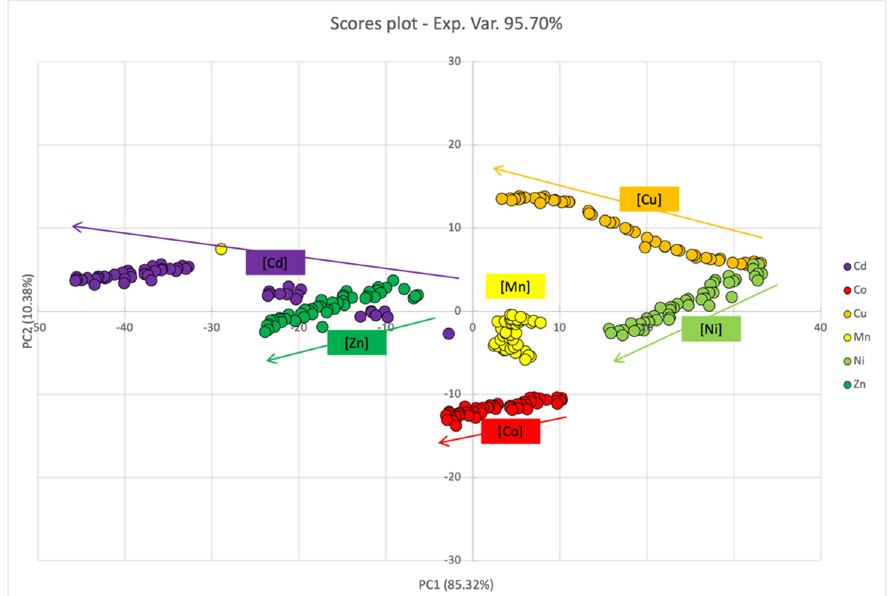
Figure 5. PCA score plot for PC1 and PC2 components upon titration of SPABs of ML– AgNPs@11MUA with each metal ion.